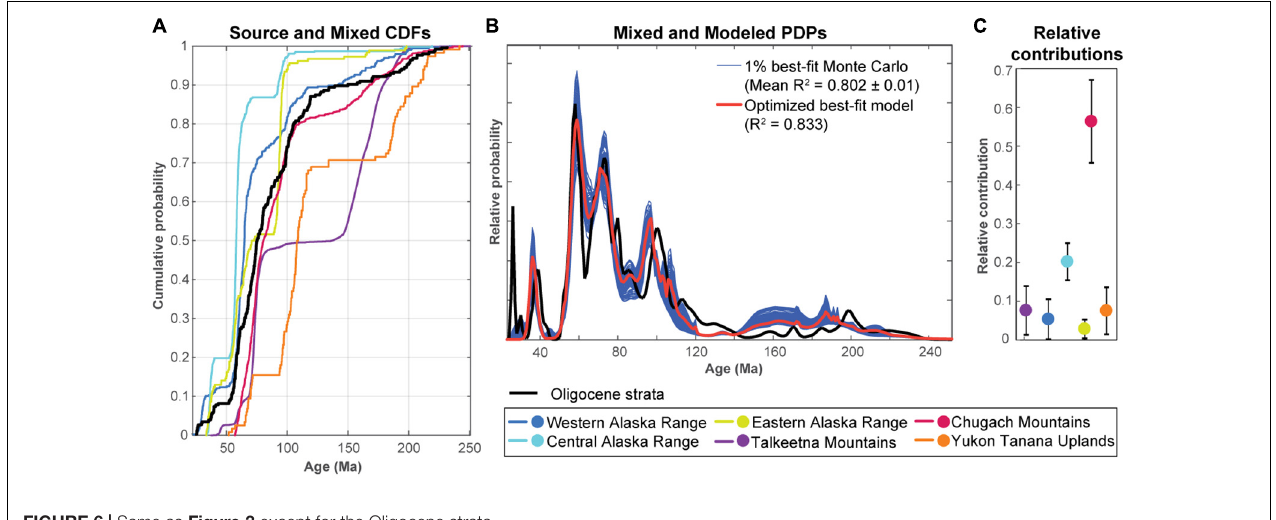
FIGURE 6 | Same as Figure 3 except for the Oligocene strata.